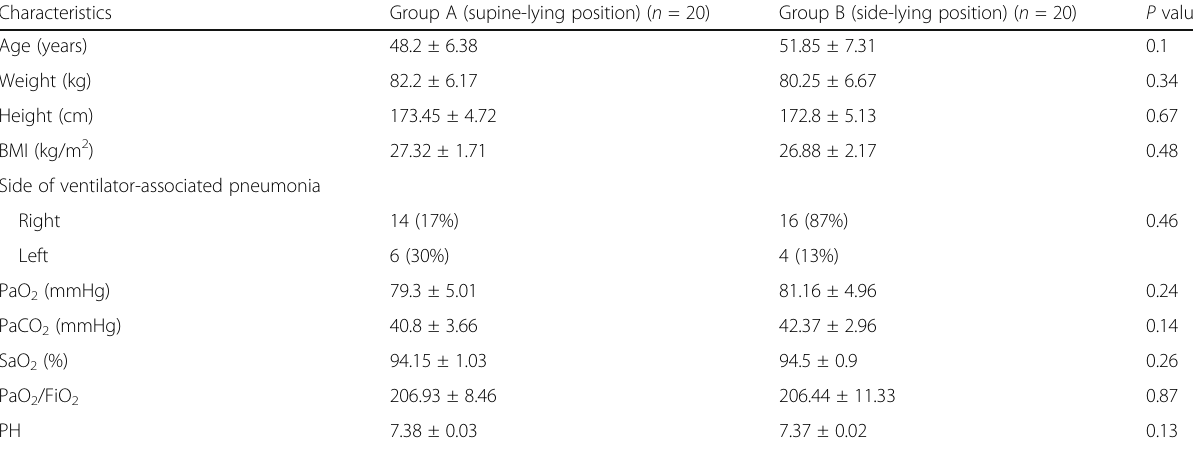
Table 1 Demographic and baseline clinical characteristics of patients in both groups